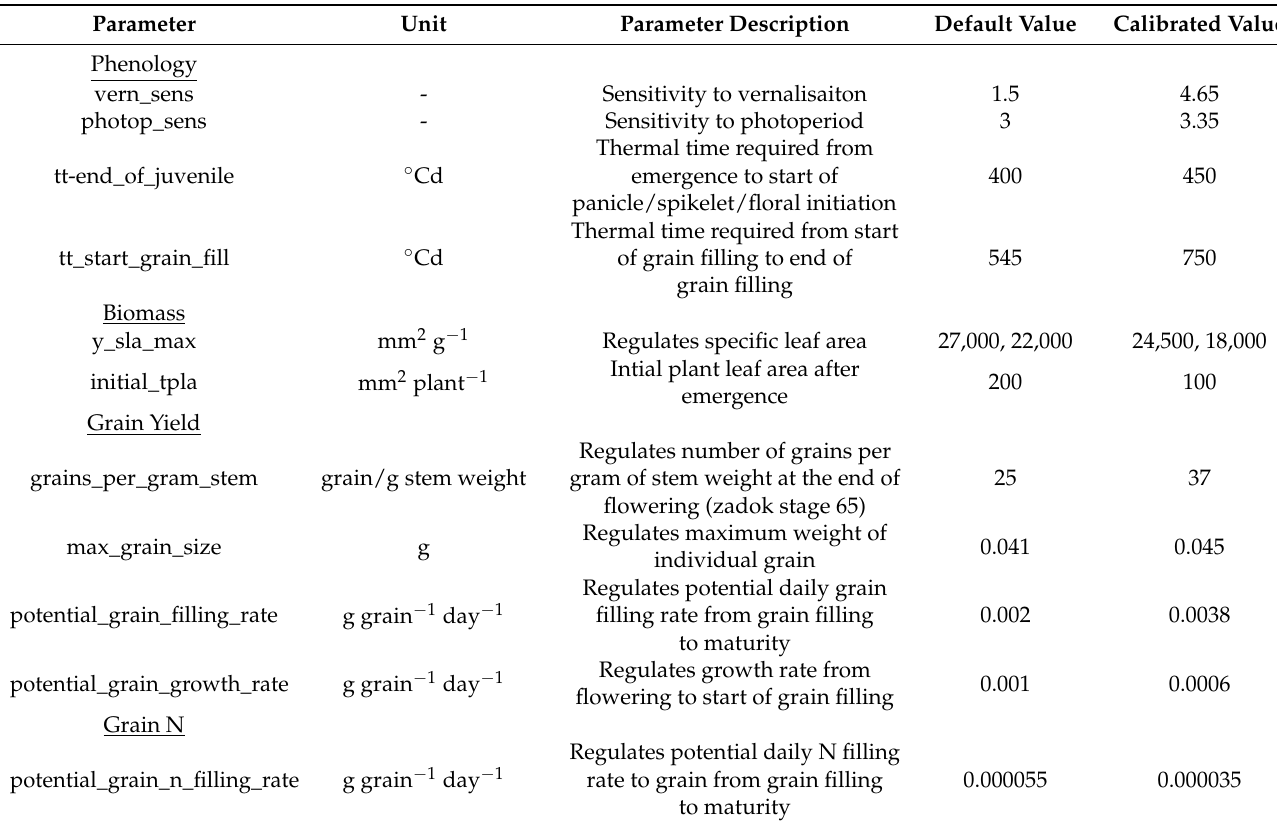
Table 5. Parameters used for calibrating APSIM winter wheat phenology, biomass accumulation, grain yield, grain N, and N